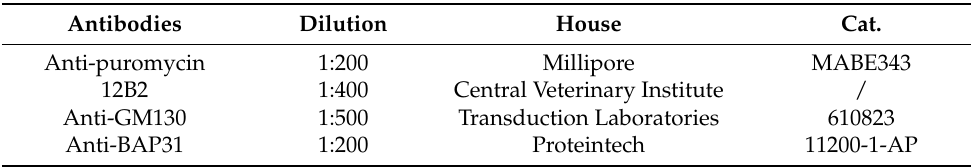
Table 1. Primary antibodies used for IF